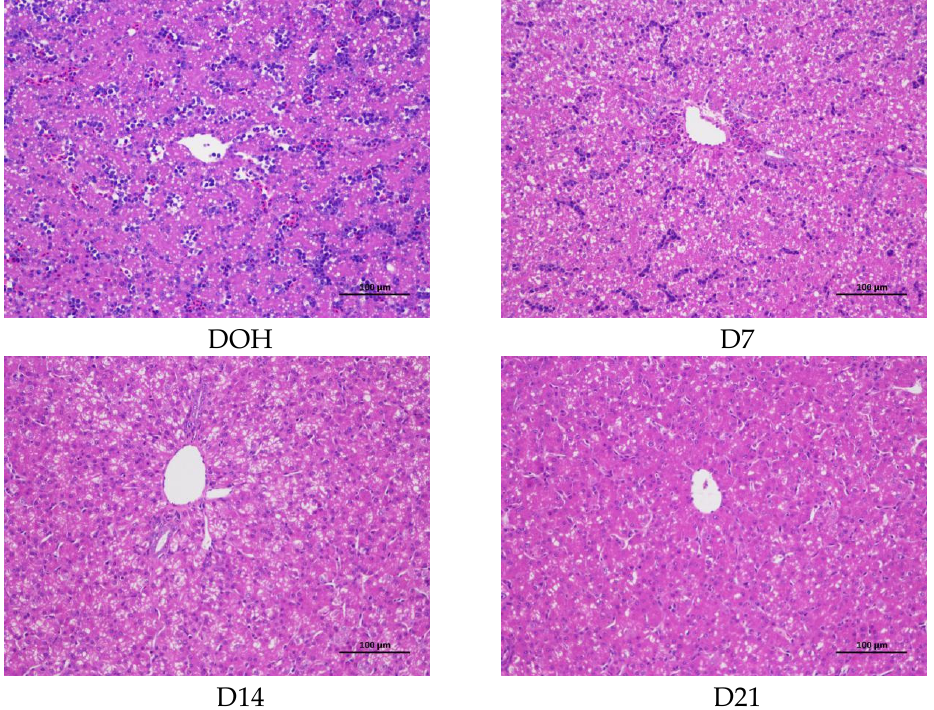
Figure 5. The age-related changes in hepatic morphology of domestic pigeon squabs. DOH = day of hatch; D7 = day 7 post-hatch; D14 = day 14 post-hatch; D21 = day 21 post-hatch. Bar = 100 μ m.